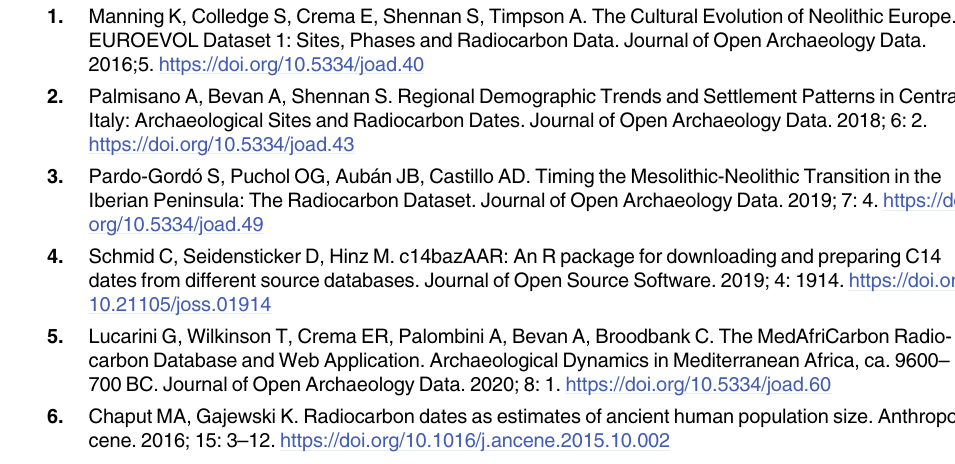
S5 Fig. Model m2 trace plots. (PDF) S6 Fig. Model m3 trace plots. S7 Fig. Time difference between earliest dated evidence of charred rice in Kyushu [93] and inferred change-point in growth rate for models 2 and 3. Differences were computed by comparing 15,000 random pairs of posterior samples from the two events. The highlighted region represents the 90% HPD density interval. Rice dates were calibrated using IntCal20 and combined using the R_Combine function in OxCal (via the OxCAAR R